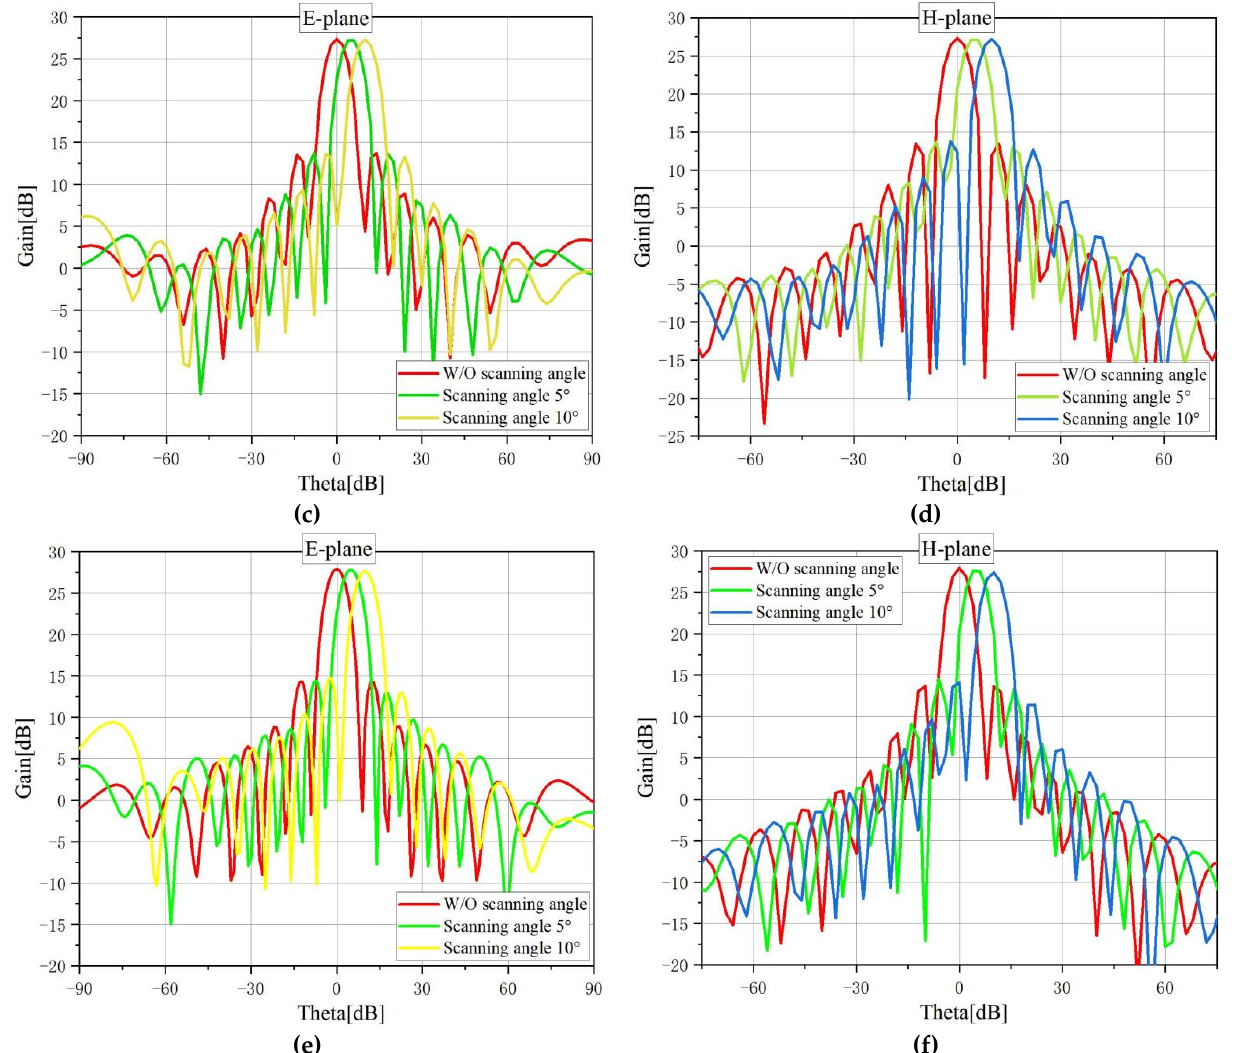
Figure 11. The simulated gain of the proposed 8 × 8 phased array antenna: (a) E ‐ plane at 7.5 GHz, (b) H ‐ plane at 7.5 GHz, (c) E ‐ plane at 8 GHz, (d) H ‐ plane at 8 GHz, (e) E ‐ plane at 8.5 GHz, and (f) H ‐ plane at 8.5 GHz.